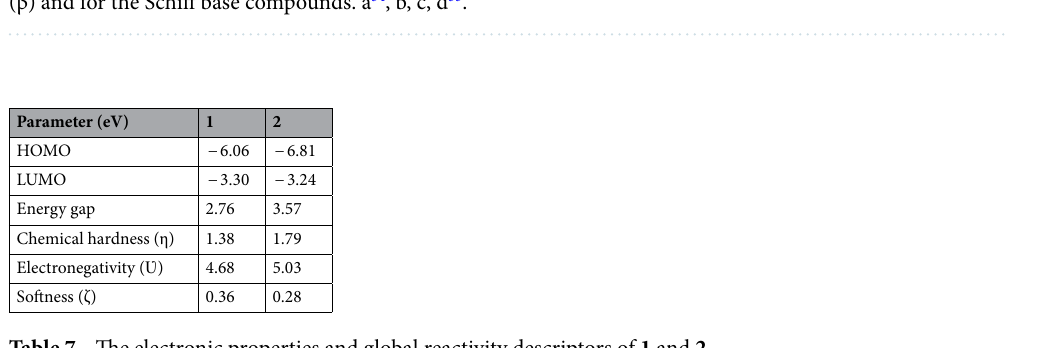
Table 7. The electronic properties and global reactivity descriptors of 1 and 2 .